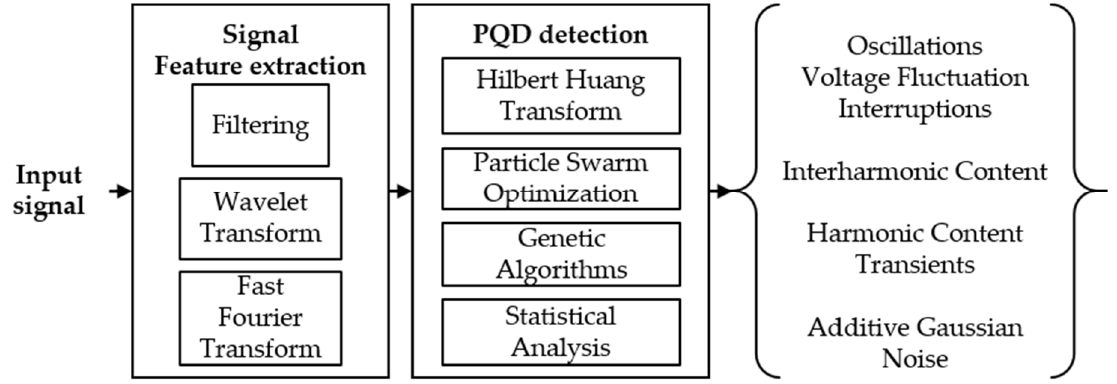
Figure 9. Block diagram of extraction and detection of PQDs.